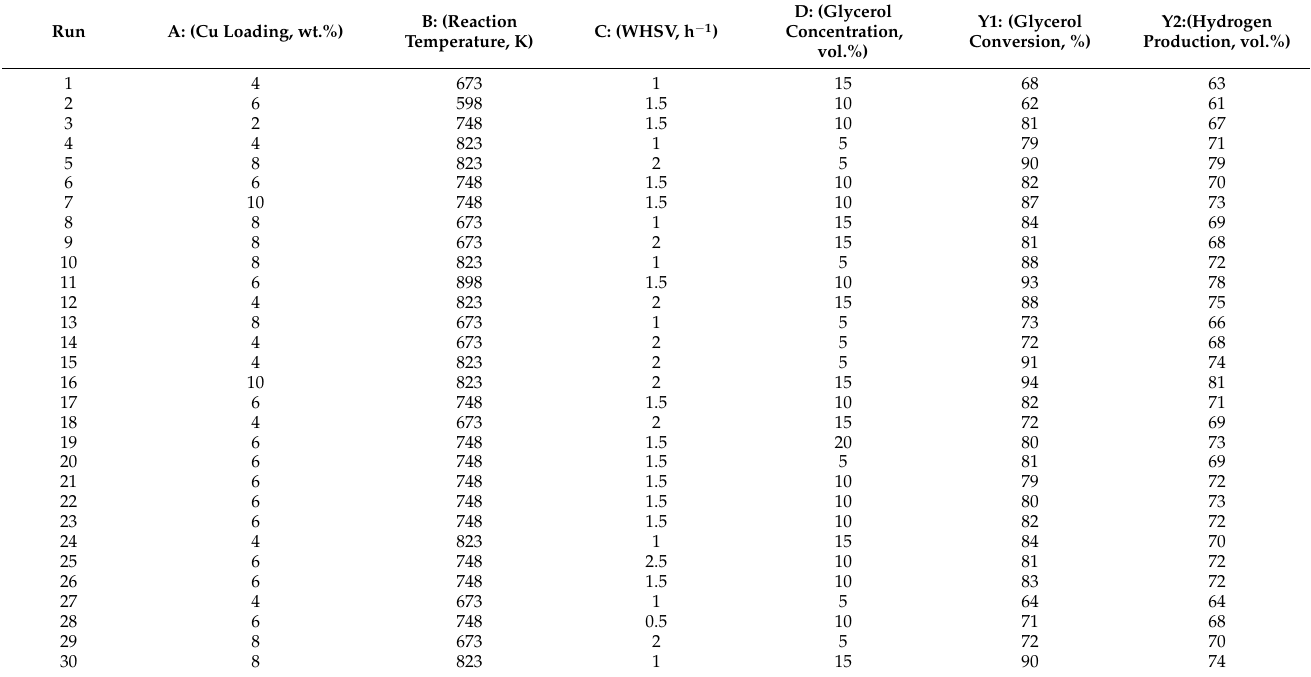
Table 6. Set of design of experiments based on CCD